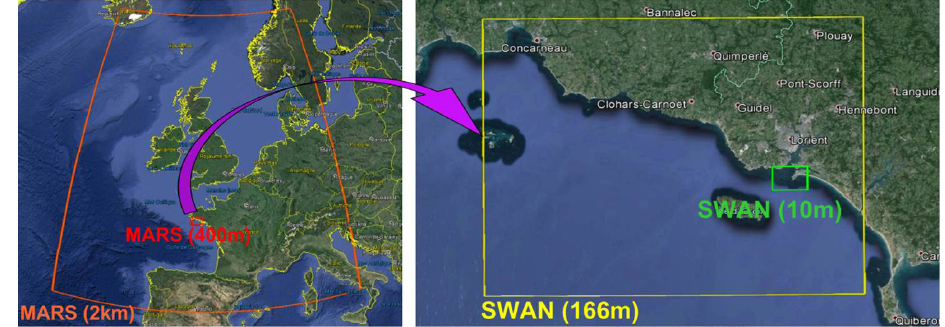
Figure 2. Location map of Gâvres, areas covered by the regional and coastal simulations (sea water level with MARS on the left, wave characteristics with SWAN on the right).